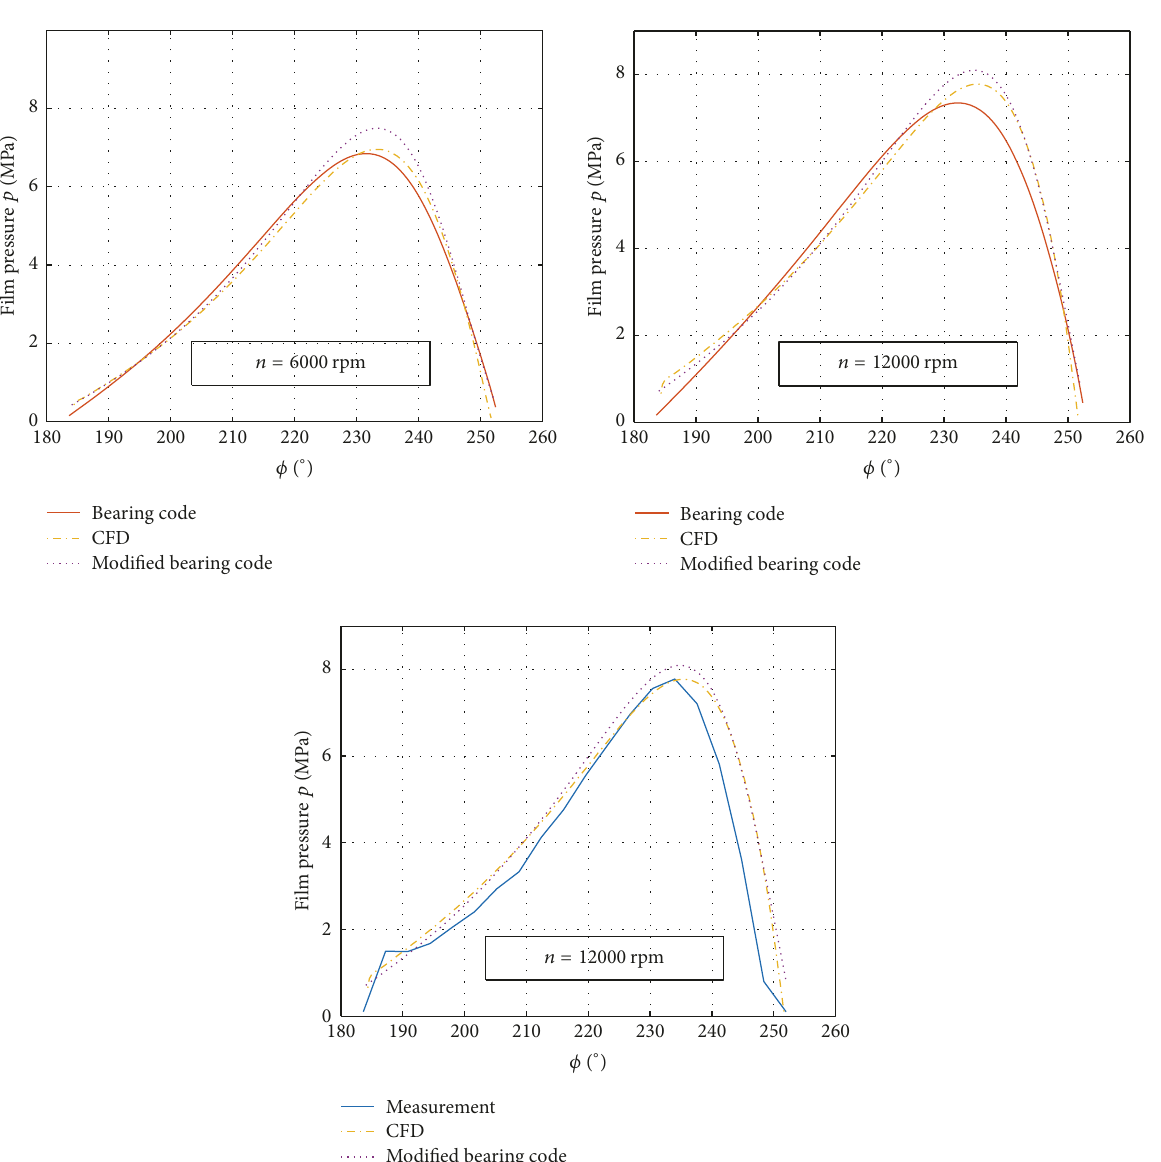
Figure 14: Comparison of measured and predicted pressure distributions on pad number 3 considering enhanced boundary conditions (TPB120, 𝑝 𝑞 = 2.0 MPa, 𝑄 = 90 l/min, 𝑇 sup = 50 ∘ C, and 𝑧 = 36